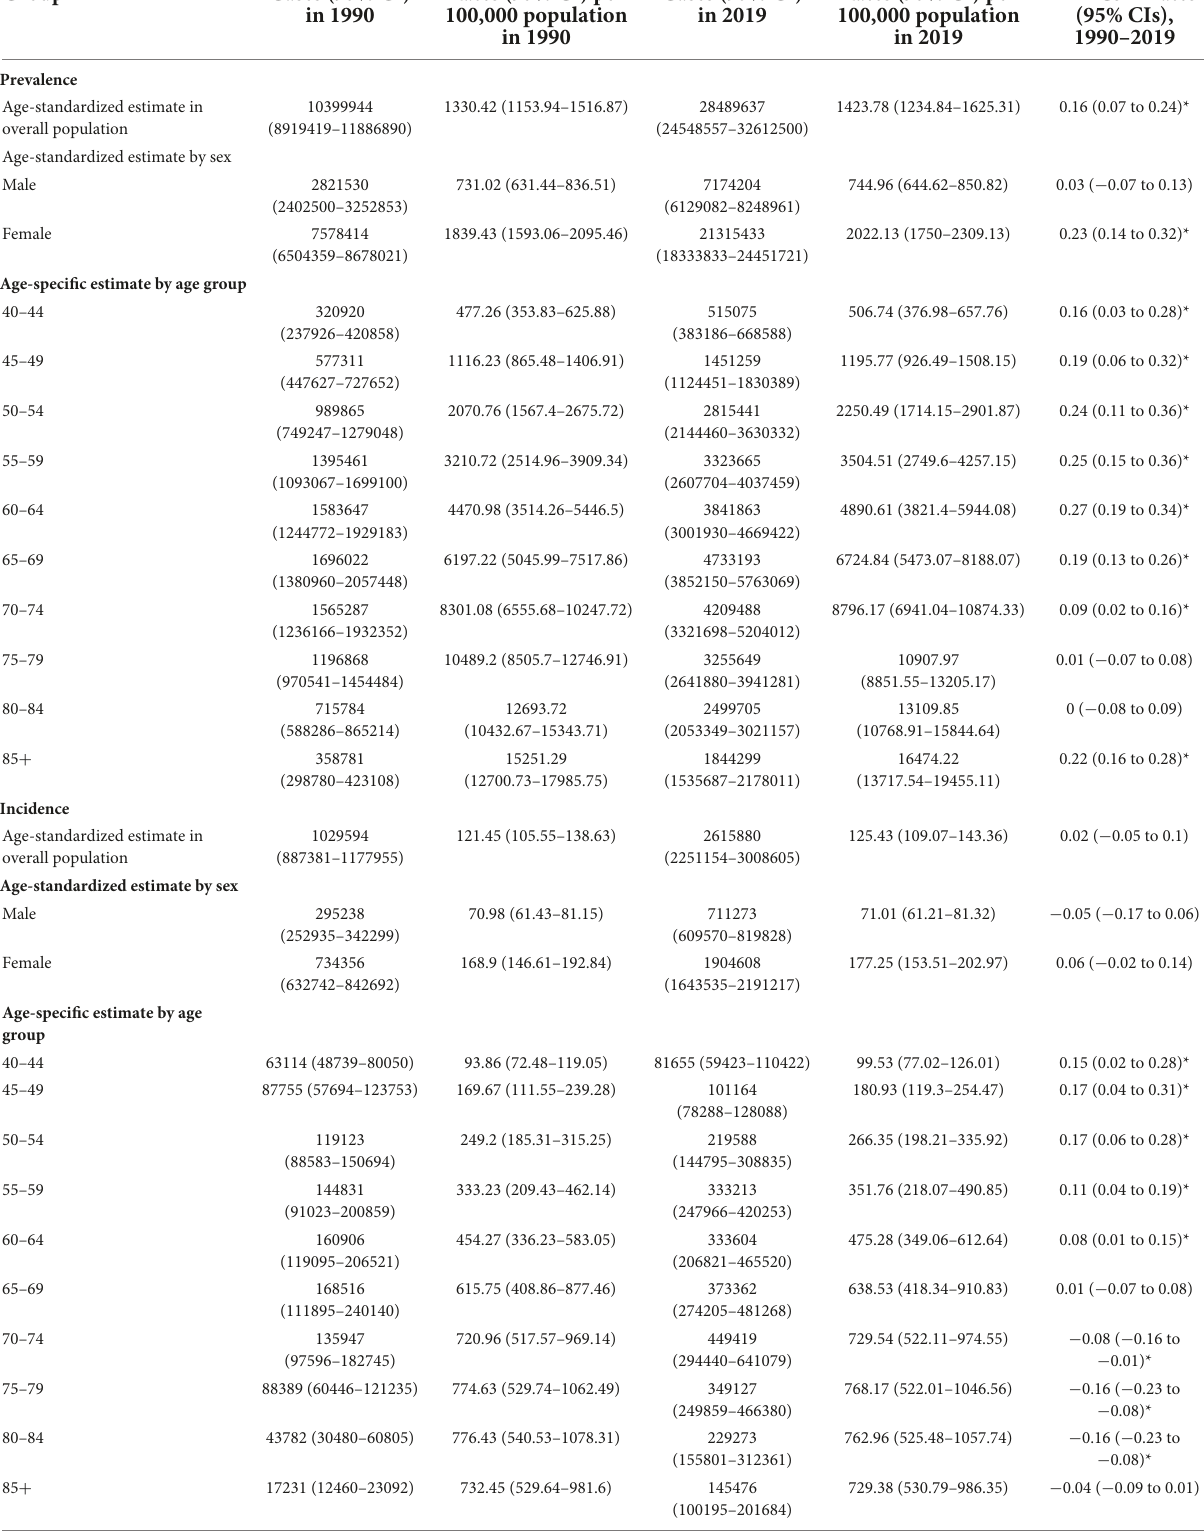
TABLE 1 Sex-and age-specific rates of peripheral artery disease in China in 1990 and in 2019 and their average annual percentage changes (AAPCs) from 1990 to 2019.